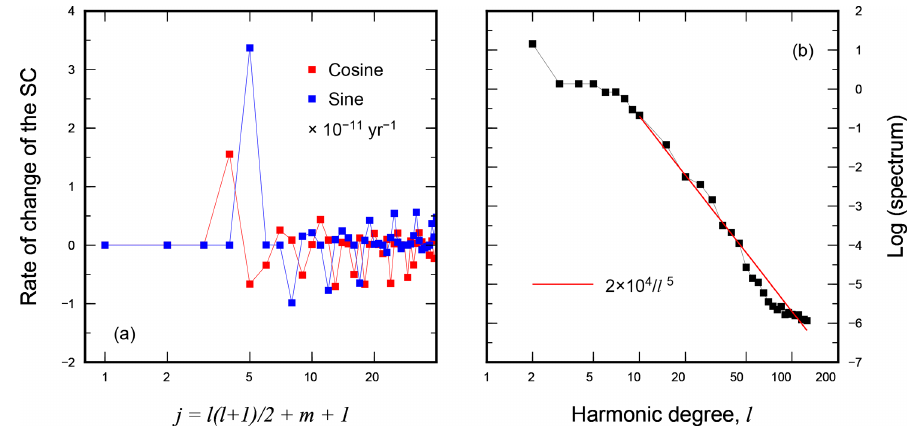
Figure 9. Present-day rate of change of the low harmonic degree ( l ≤ 6) Stokes coefficients obtained for the test run of SELEN 4 (a) and their full spectrum extended to harmonic degree l max = 128 (b) . The solid line in panel (b) represents the power law that best fits the spectrum, in the least squares sense, for l ≥